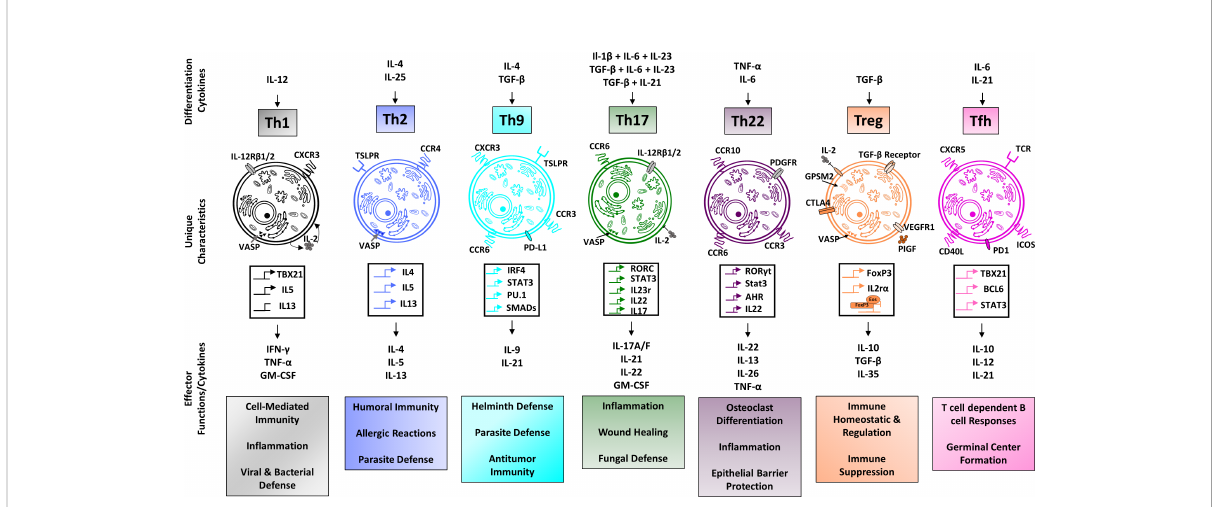
FIGURE 1 Overview of CD4+ T cell subsets. Regulatory T cells, along with the Th2 phenotype are classically associated with anti-in fl ammatory functioning, whereas Th1 and Th17 cells are typically associated with pro-in fl ammatory functions. Th9 cells are implicated in host defense against helminth infections, Th22 cells in host defense against bacterial pathogens and Tfh cells play an important role for the development of lasting immune memory. The individual characteristics and functions of CD4 + T cell subsets are made possible through distinct gene pro fi les resulting in a subtype-speci fi c expression of receptors and cytokine production. Different environmental stimuli, such as TGF- b in the case of regulatory T cells induce the differentiation of naive CD4+ T cells into their respective subtypes (14 –